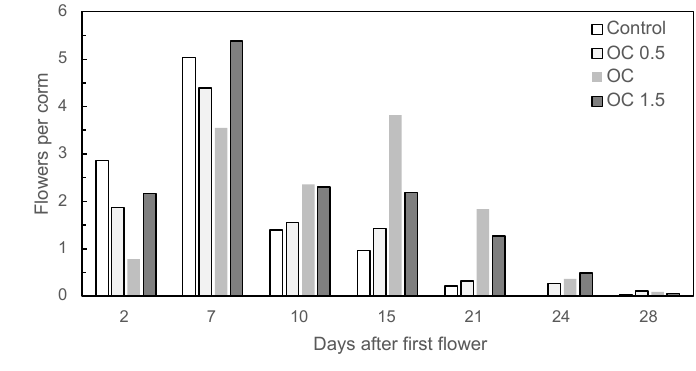
Figure 1 Flower formation in saffron plants ( Crocus sativus L.) during the flowering period. OC – optimal concentration.